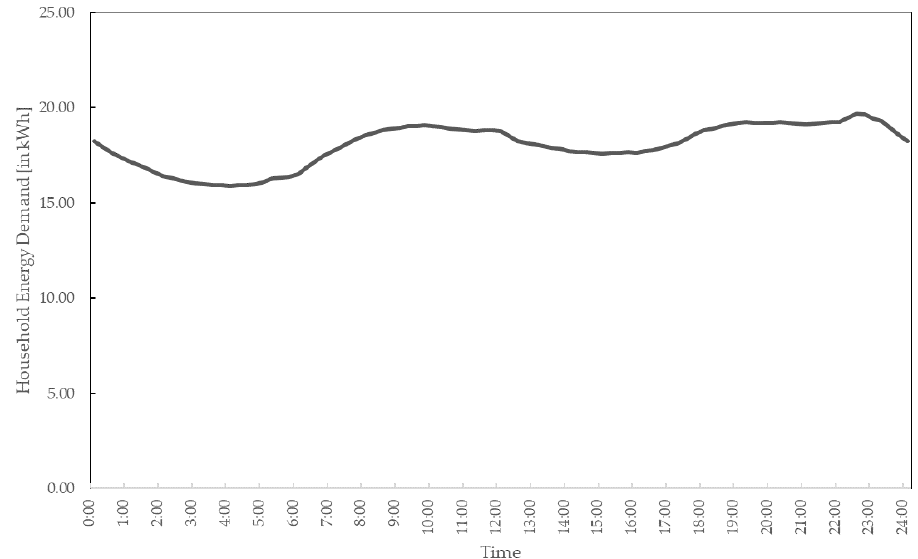
Figure 6. Household Energy Demand Data.